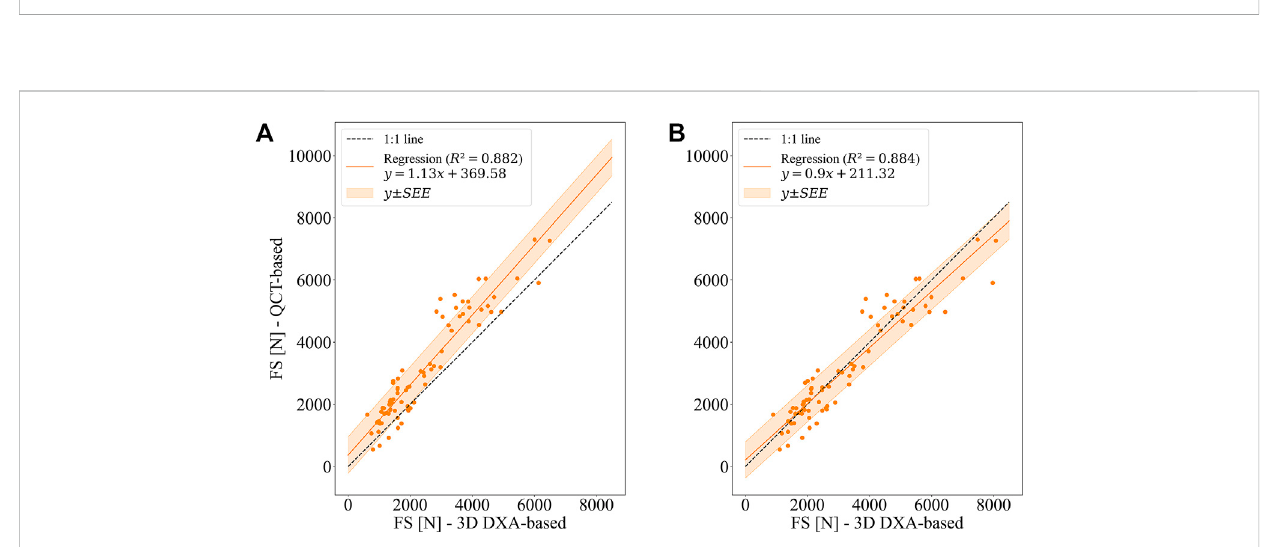
FIGURE 8 Linear regression between QCT-based and 3D DXA-based femoral strengths (FS) for the side fall con fi guration. (A) Uncorrected 3D DXA-based FE simulations (B) BMC of 3D DXA-based meshes adjusted to BMC of QCT-based meshes (collectively corrected 3D DXA-based FE simulations).